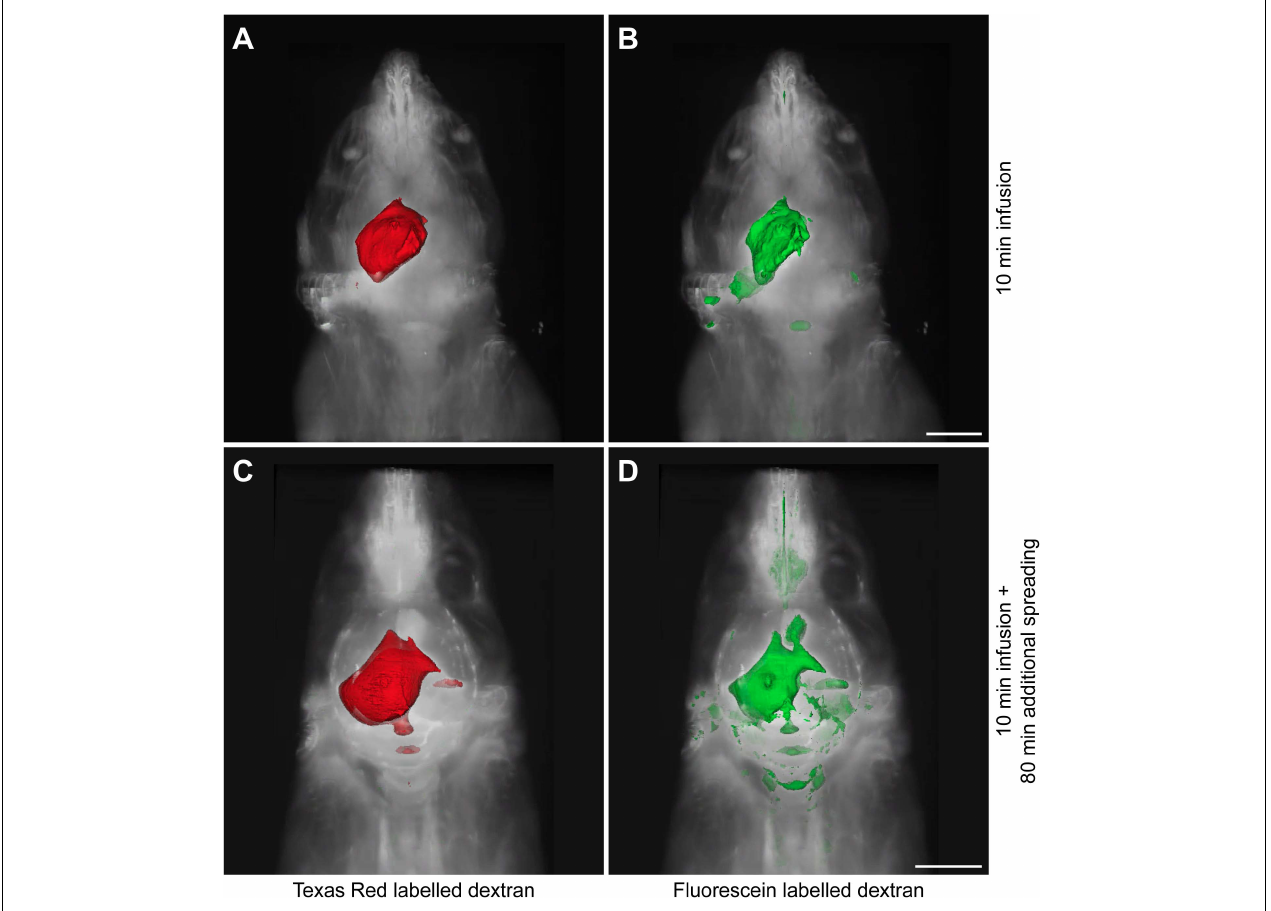
FIGURE 1 | Representative 3D reconstructions of the tracer distribution through the body. The polygon meshes delineate regions above a fixed intensity threshold that was kept constant for each fluorescent tracer. (A,B) The dispersion of Texas Red labeled and fluorescein labeled dextrans after the infusion period of 10 min. (C,D) The spreading pattern of the same fluorescent tracers after an additional spreading period of 80 min that followed the infusion period of 10 min. Scale bar represents 5000 µ